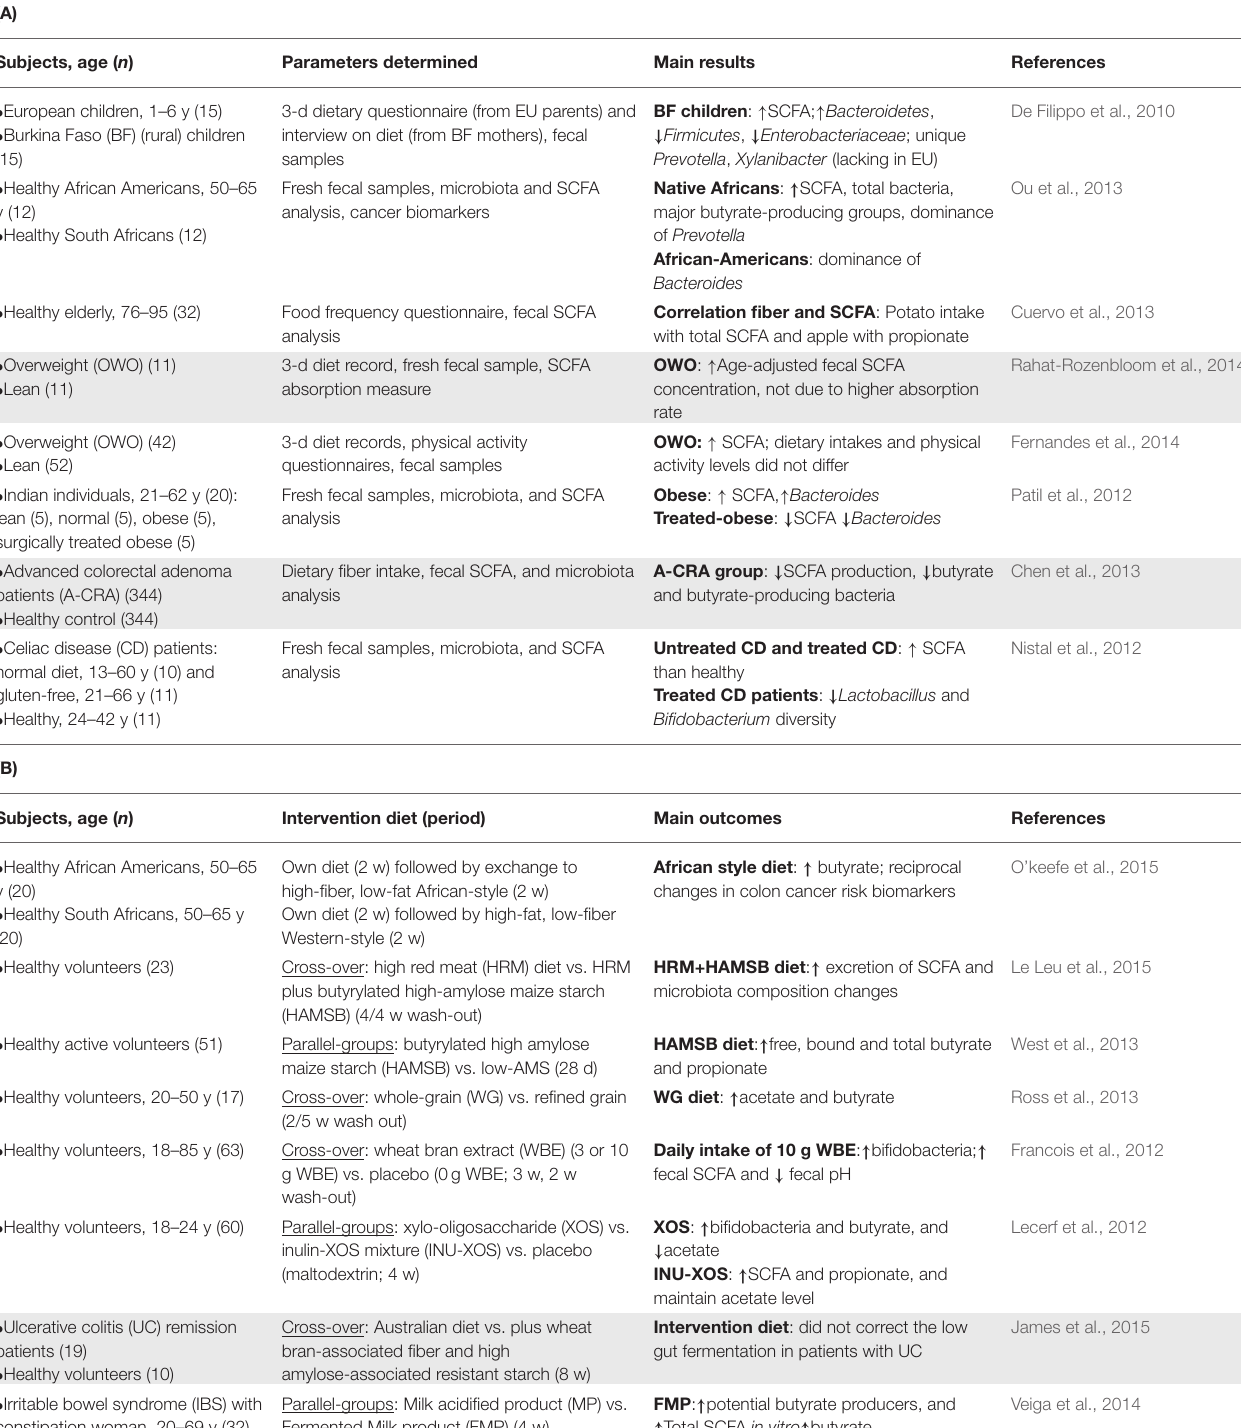
TABLE 1 | (A) Epidemiological studies, carried out since 2010, showing the impact of diet on SCFA produced by the gut microbiota. The shaded areas indicate a change in the populations analyzed in terms of their health status. D, days; y, year. (B) Intervention studies, carried out since 2010, showing the impact of diet on SCFA produced by the gut microbiota. The shaded areas indicate a change in the populations analyzed in terms of their health status. D, day; w, week; m, month; y,